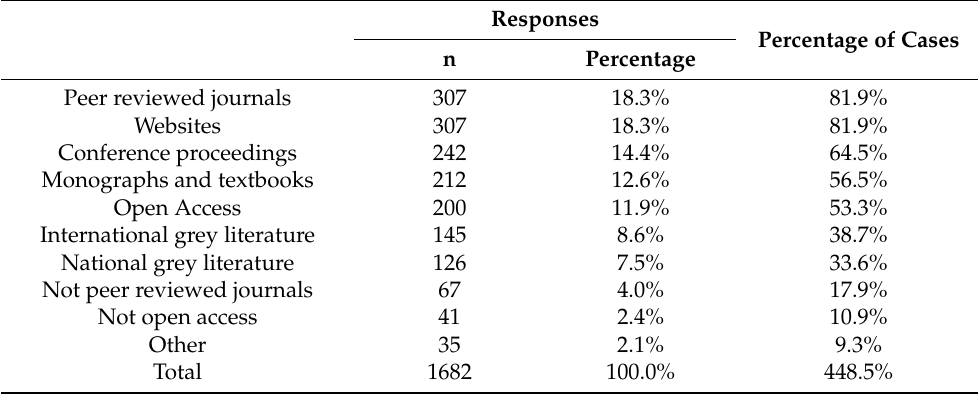
Table 4. Sources consulted for professional training in OSH. Multiple choice